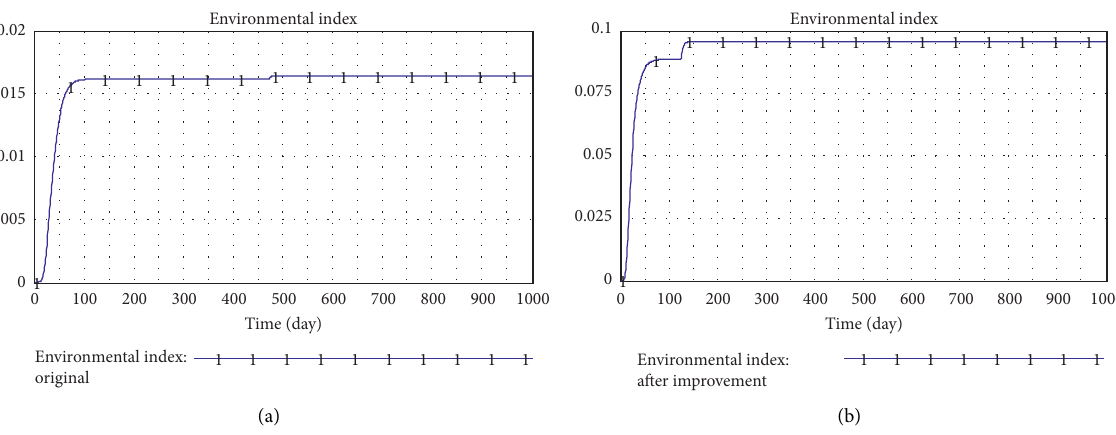
Figure 8: Comparison of environmental index between (a) the original model and (b) the improved model.